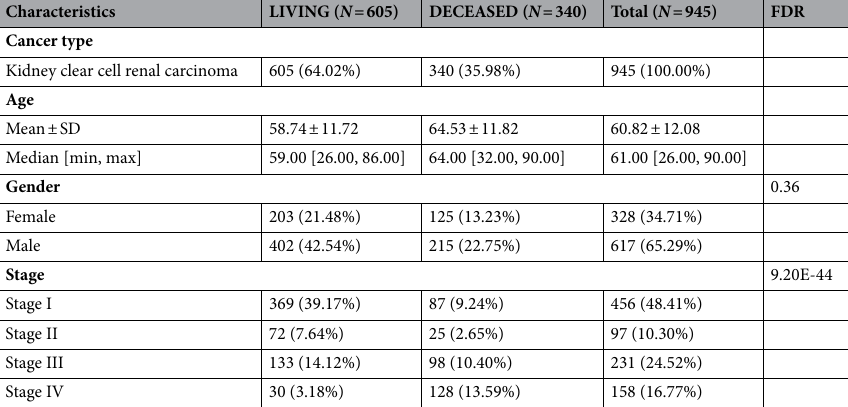
Table 1. The clinical information and sample size for TCGA KIRC dataset.